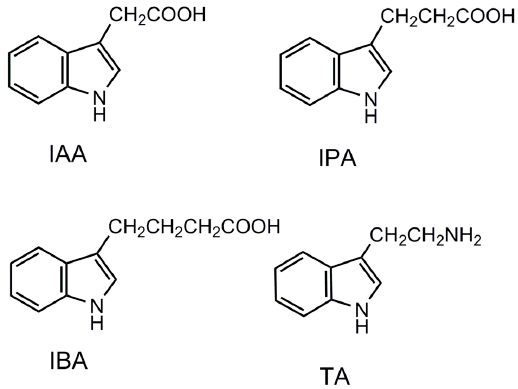
Figure 5. Molecular structures of IBA and its analogues IAA, IPA, and TA.